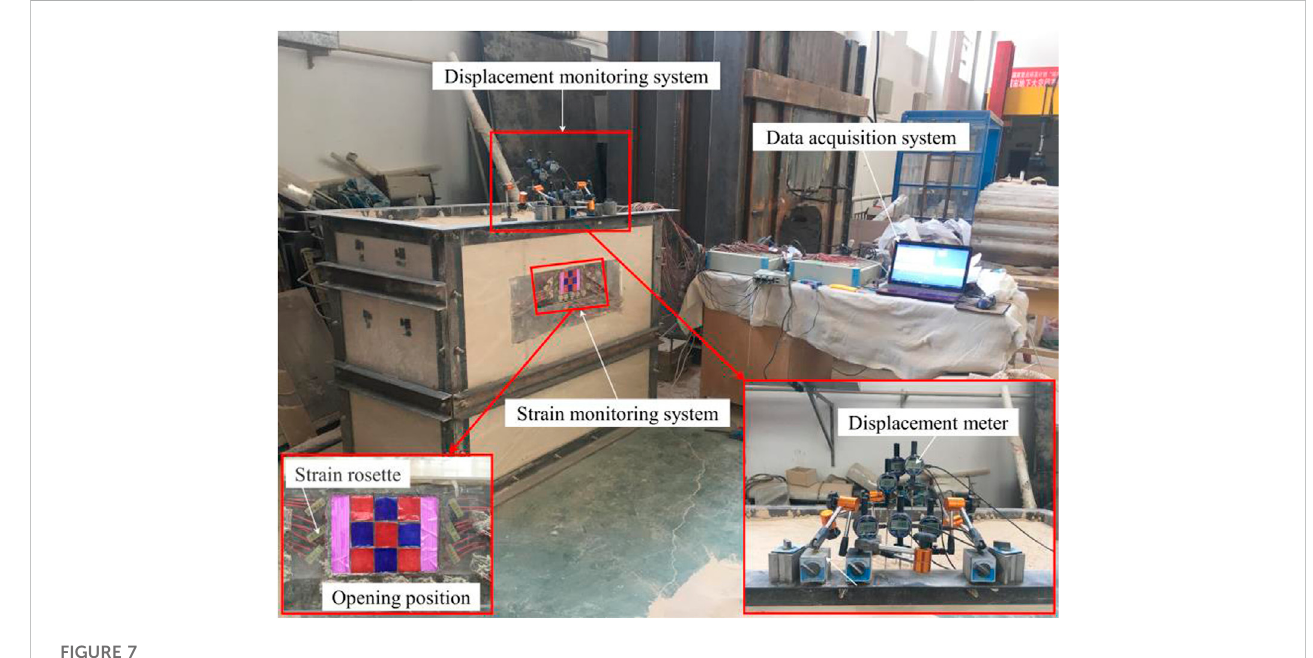
FIGURE 7 The model test device of side wall